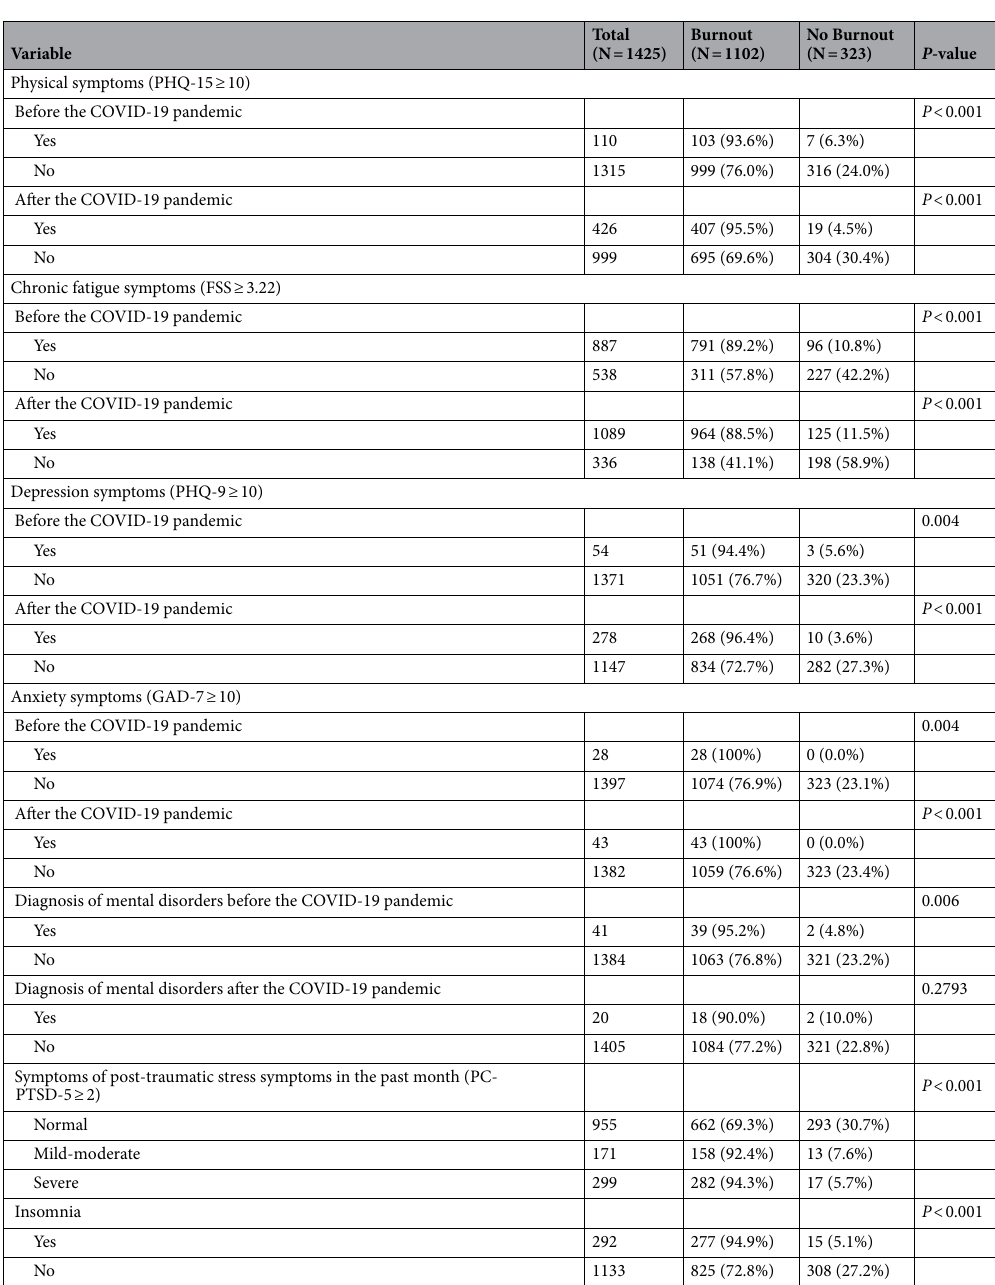
Table 4. Burnout rate according to the presence of physical and mental symptoms before and after the COVID-19